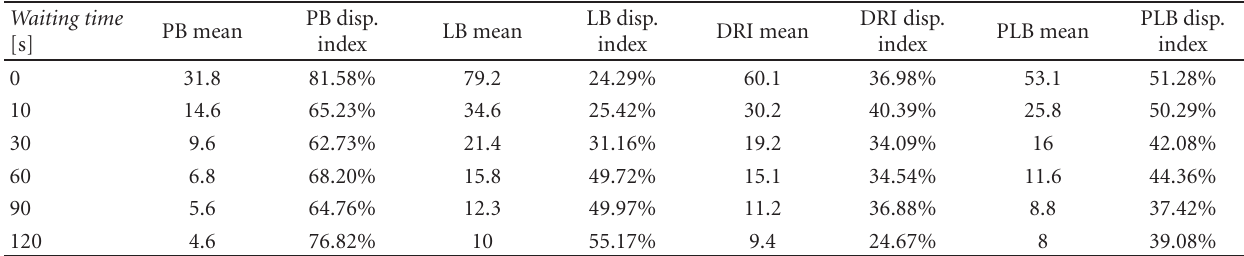
Table 2: Statistics for the number of VHO occurrences for PB, LB, DRI-VHO, and PLB-VHO approaches. Waiting